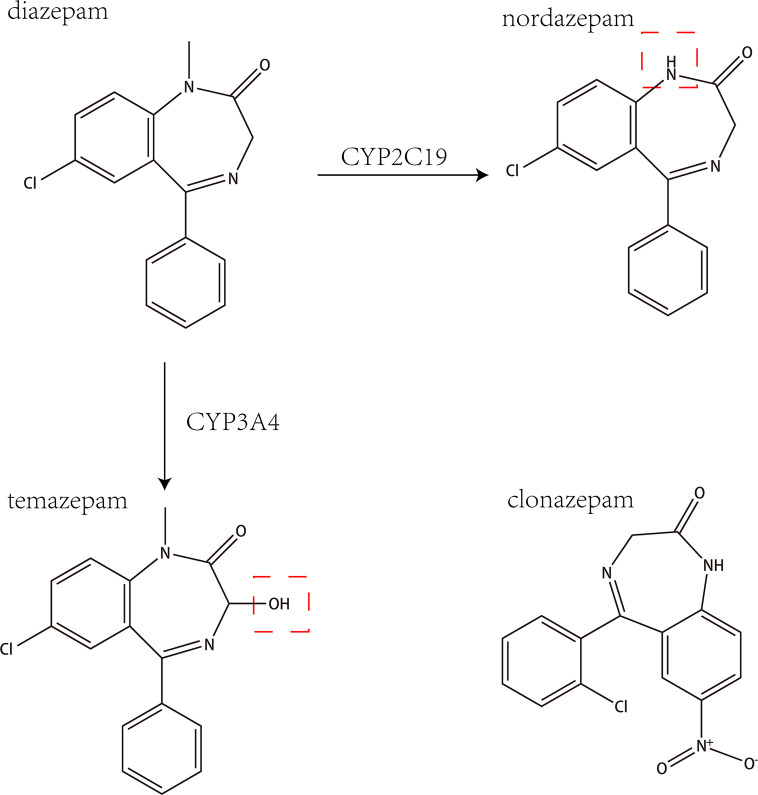
The chemical structures and mass spectra of diazepam, nordazepam, temazepam, and clonazepam (internal standard).